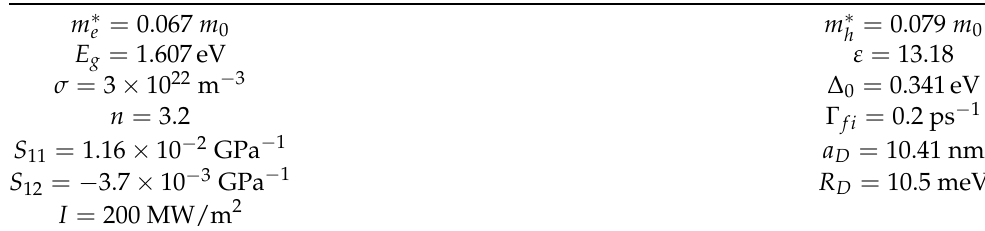
Table 1. Physical parameters of GaAs and light properties [50].